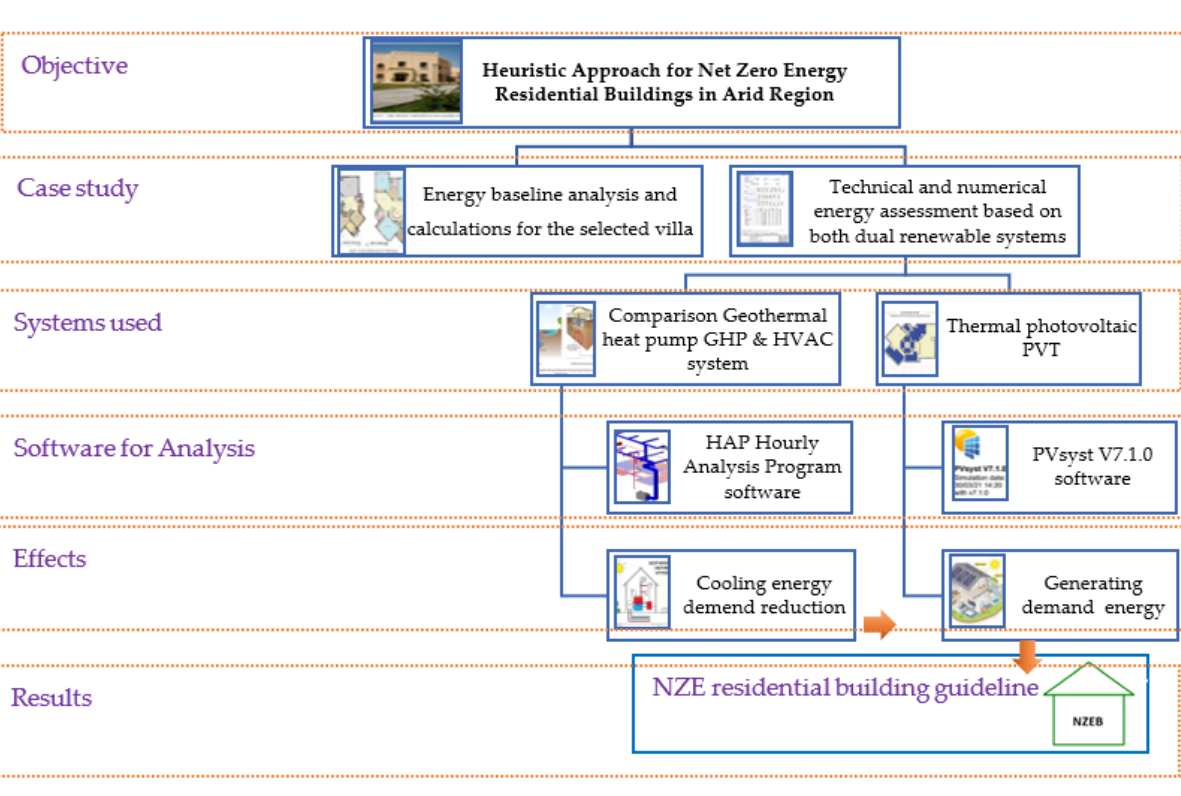
Figure 3. The study method flowchart.